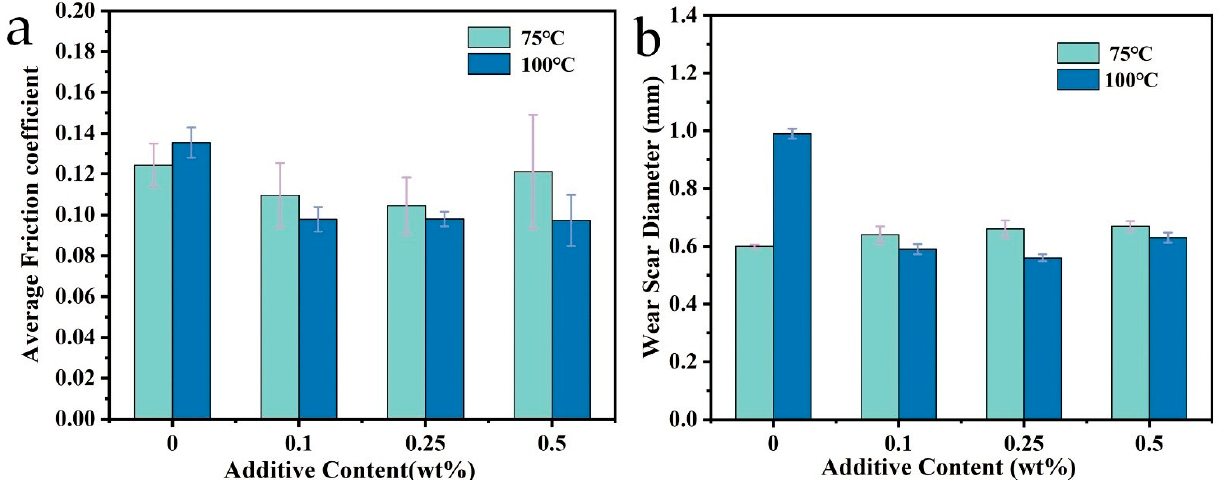
Figure 5. ( a ) average coefficient of friction (AF) and ( b ) average wear scar diameter (AWSD) diagram of different IF–WS 2 contents at 75 °C and 100 °C. Table 1. Average COF values at different time.